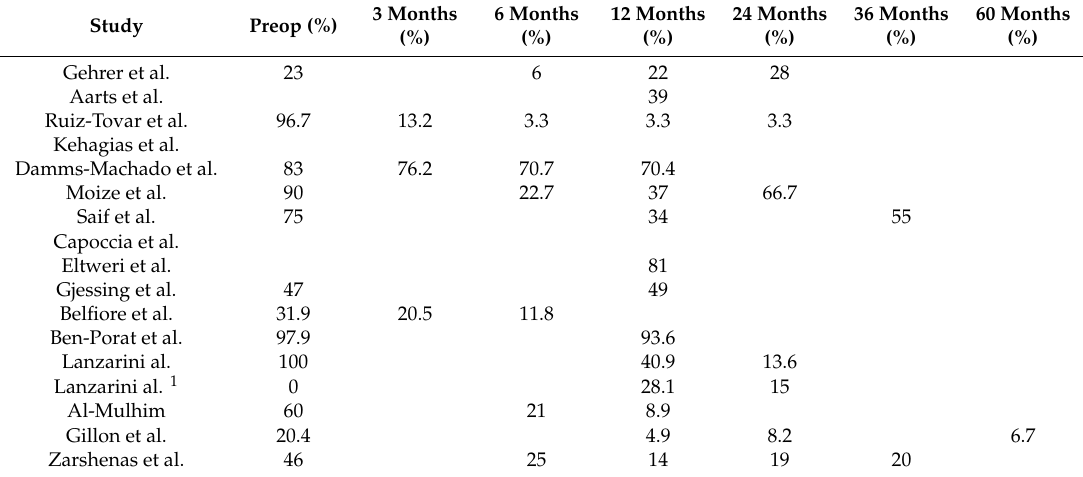
Table 6. Vitamin D: Percentage (%) of patients with deficiencies at each postoperative